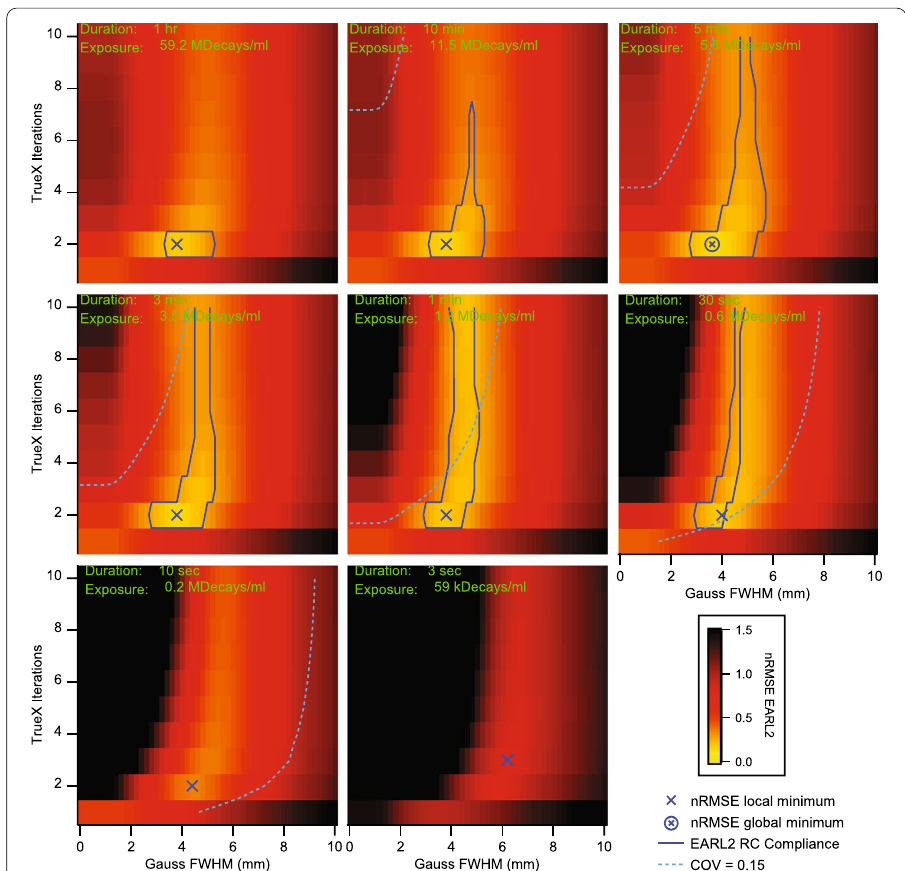
Fig. 4 Normalized RMSE for RCmax and RCmean in reconstruction parameter space. Data sets within the blue contour passed the current EARL2 recovery curve limits; each panel represents a different exposure. The light blue dotted lines mark the EARL COV cut‑off values from Fig. 1; compliant data sets were found on the dotted line’s right side. The blue cross marks the local nRMSE minima; the cross in the circle marks the global nRMSE minimum. Panels are shown in order of decreasing